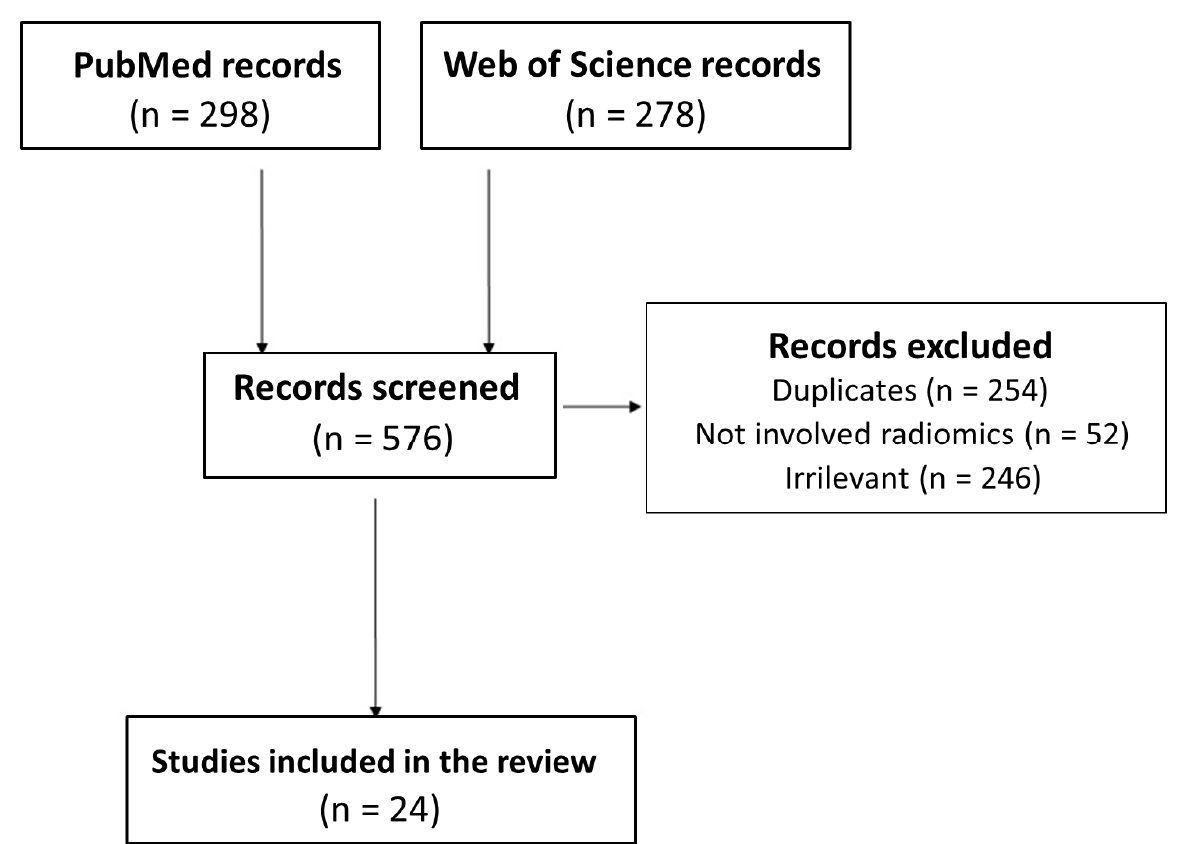
Figure 2. PRISMA flowchart of the study.